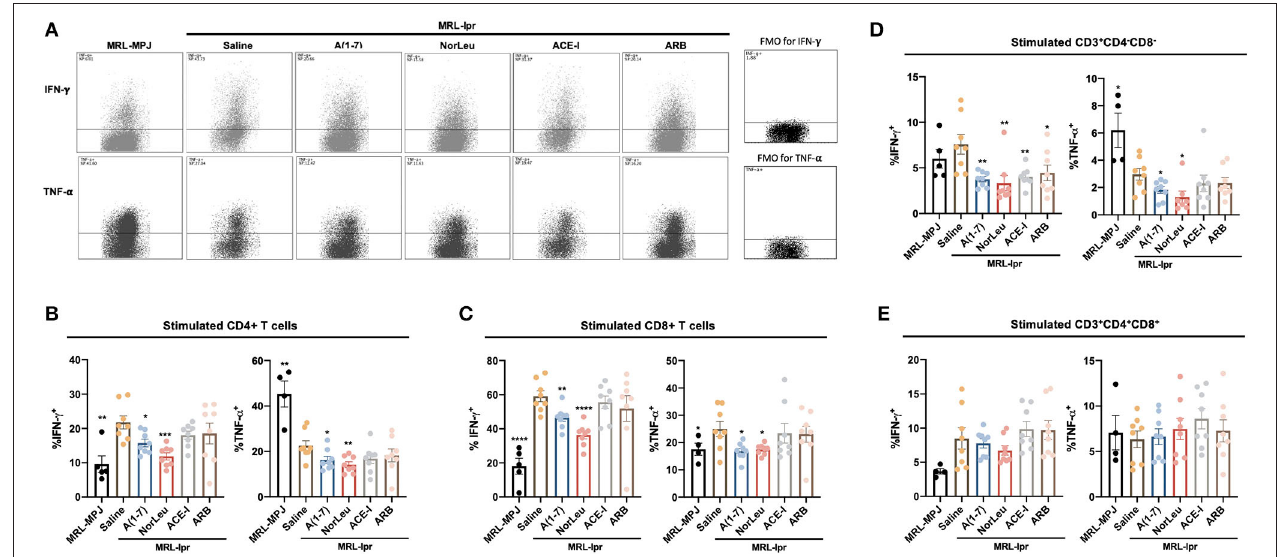
FIGURE 4 | T cells producing pro-inflammatory cytokines are seen in higher levels in MRL -lpr mice and reduce with A(1-7) and NorLeu treatment. Splenic cells were stimulated for 16h with PMA/ionomycin and then stained with T cell markers and for IFN- γ and TNF- α production. The gating strategy for the T cell characterization can be found in Supplemental Figure 7 . (A) Representative plots show samples of CD4 + Tcells expressing IFN- γ and TNF- α after stimulation. The percent of (B) CD4 + and (C) CD8 + T cells that express IFN- γ and TNF- α were measured. The percentage of cells producing IFN- γ and TNF- α in the unusual (D) CD3 + CD4 − CD8 − and (E) CD3 + CD4 + CD8 + populations were also measured. Statistics were run using Prism 8.4.0, t -tests were used to compare all groups to saline treated MRL -lpr mice; * p ≤ 0.05, ** p ≤ 0.01, *** p ≤ 0.001, **** p ≤ 0.0001.